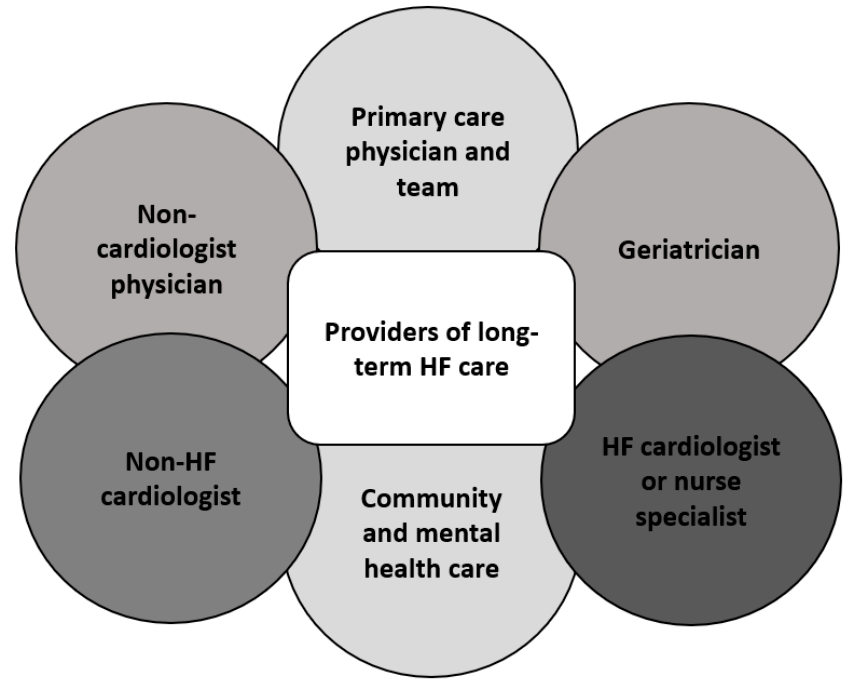
Figure 3. Providers of long-term heart failure care.